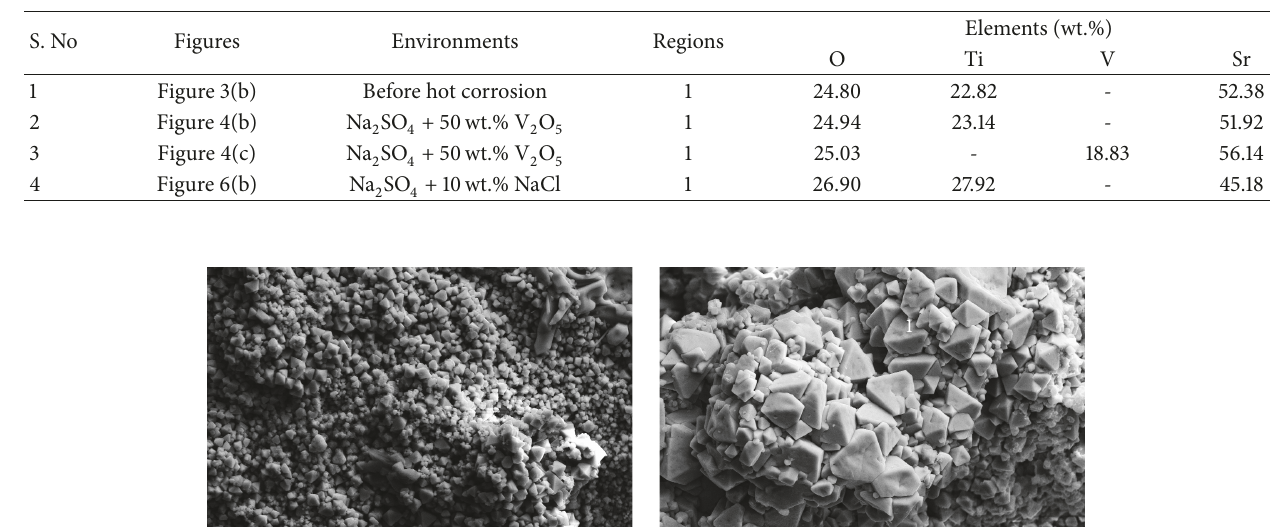
Table 1: The elemental compositions of SrTiO 3 samples before and after being subjected to hot corrosion in both Na 2 SO 4 + 50 wt.% V 2 O 5 and Na 2 SO 4 + 10 wt.% NaCl environments at 900 ∘ C.